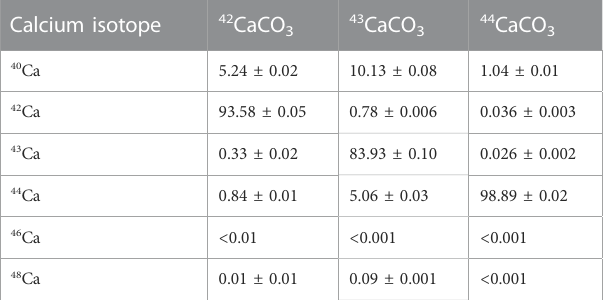
TABLE 1 Isotopic composition of enriched CaCO 3 material received from the DOE National Isotope Development Center. Calcium